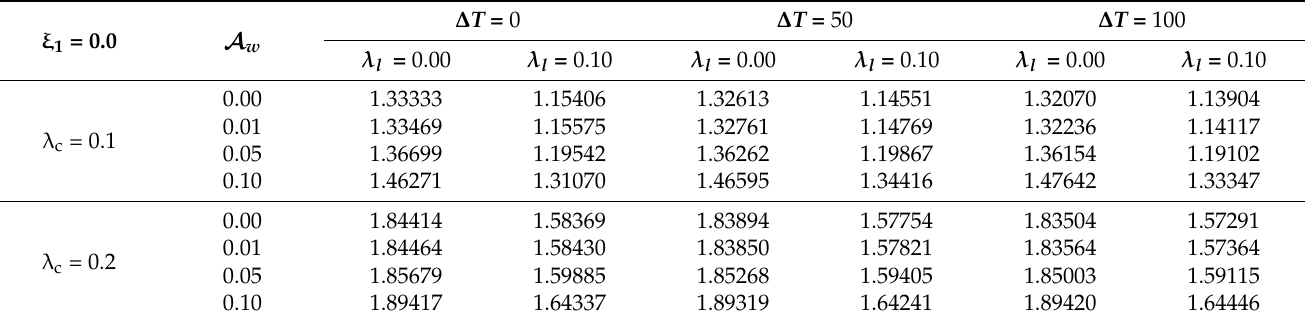
Table 15. Nonlinear dimensionless natural frequencies of porous FG clamped–clamped (C–C) nano- beam for ξ 1 = 0.0 in the case of Third-Order Hamiltonian Approach.